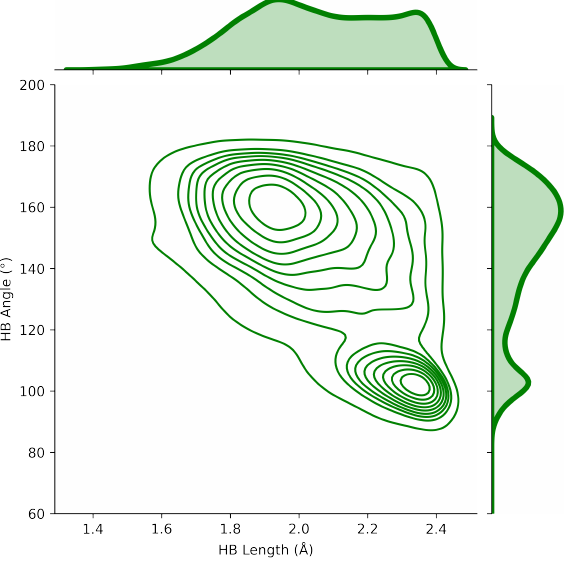
Figure 4. Hydrogen bond length and hydrogen bond angle deviation in database